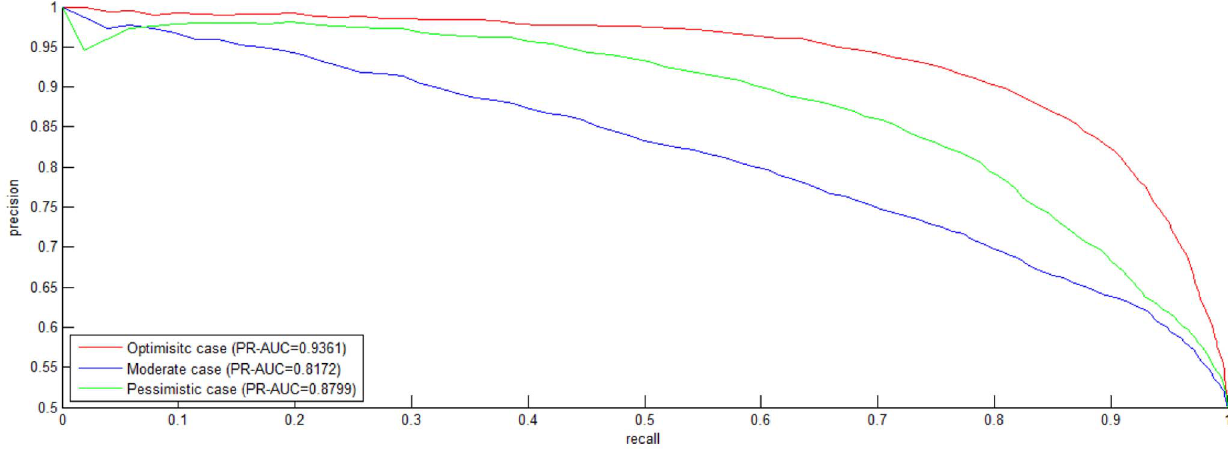
Figure 2. Precision-Recall(PR)curve on S1 dataset. The negative data is constructed by the negative data sampling method of exclusiveness of subcellular co-localized proteins . The PR curves in red, blue and green indicate the performance for the Optimistic case, the Moderate case and the Pessimistic case, respectively.